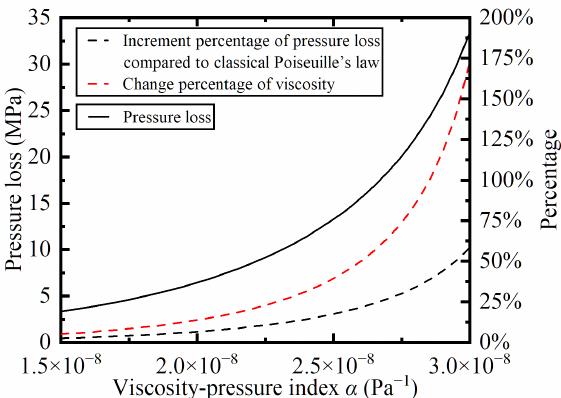
Figure 10. Pressure loss versus viscosity-pressure index.